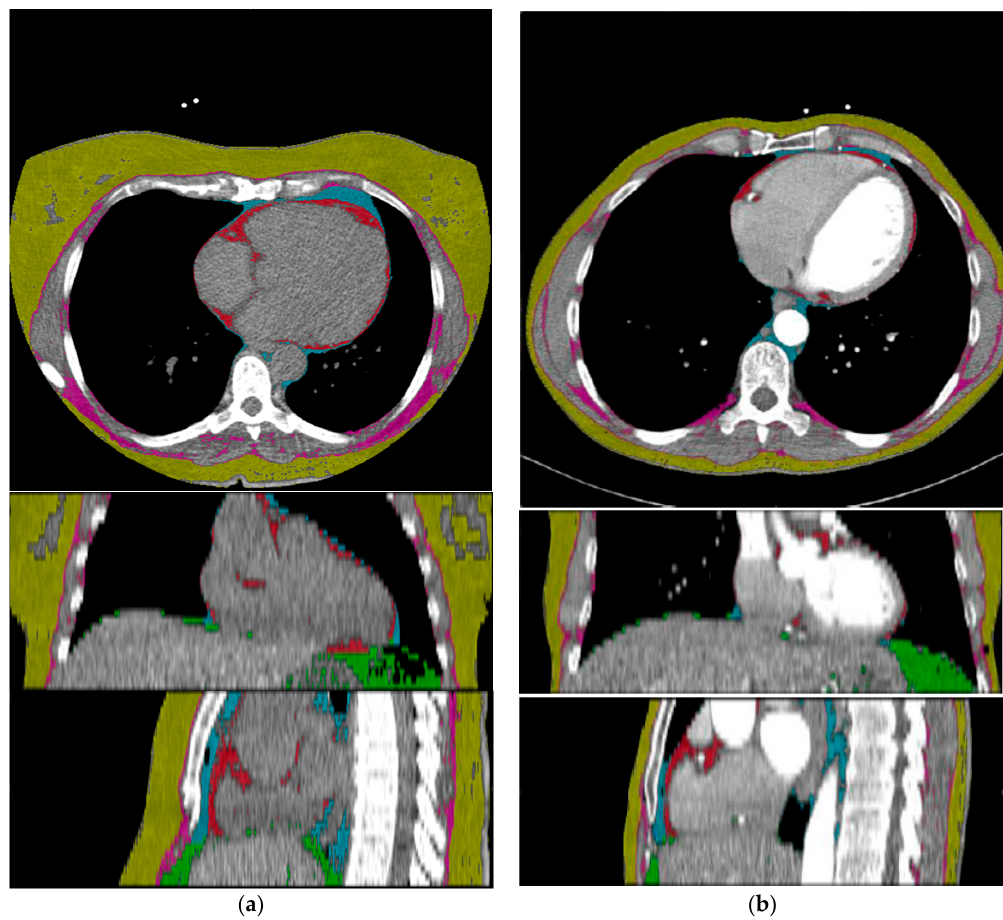
Figure 1. Exemplary adipose tissue predictions of a non-contrast-enhanced Chest CT ( a ) and a contrast-enhanced Chest CT scan ( b ). Description of labels and colors: yellow: subcutaneous adipose tissue, pink: intermuscular adipose tissue, cyan: PAT, red: EAT, green: visceral adipose tissue.